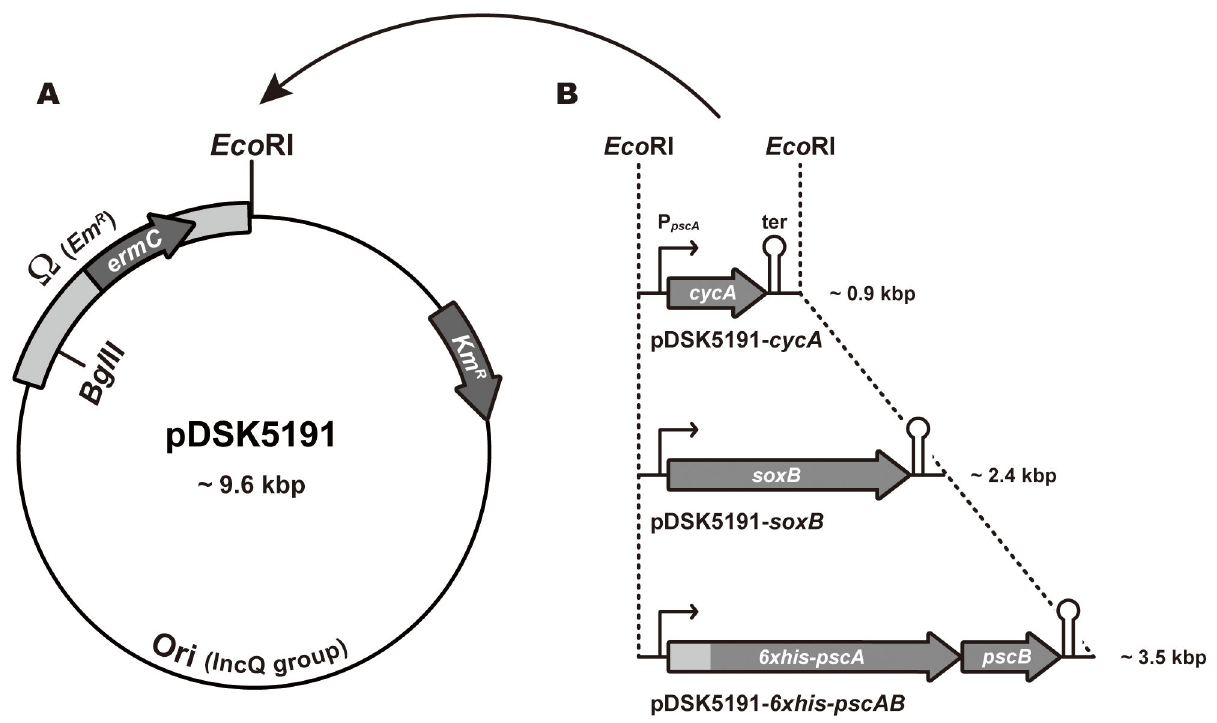
Figure 1. Schematic genetic maps of pDSK5191 and its derivative expression plasmids. (A) Genetic map of the IncQ-group conjugation plasmid pDSK5191. Protein coding sequences are shown as block arrows. The pale gray rectangle represents the region of Ω-cassette in which T4-phage transcription and translation terminator sequences [23] are located at both ends. “Ori” represents the region containing the oriV and oriT sequences, which are derived from RSF1010 and are required for replication and mobilization of the plasmid, respectively [15]. (B) Expression constructs of the pDSK5191-derivative plasmids. Each construct was inserted into the unique Eco RI site of pDSK5191, as indicated by the arch-shaped arrow at the top of the panels. Protein-coding sequences are shown as block arrows. The pale gray rectangle represents the six-consecutive histidine-tag (6xhis) attached to the 5’ end of the pscA gene. “P ” and “ter” are a putative constitutive promoter and a ρ-independent transcription terminator, pscA respectively, of the C. tepidum pscAB gene